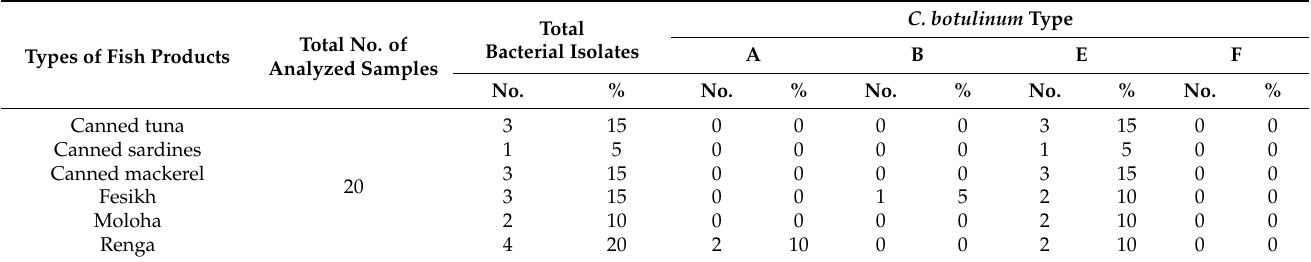
Table 2. Detection of C. botulinum types (A, B, E, and F) in fish product samples from the Beheira governorate.